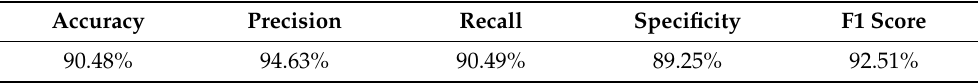
Table 3. Performance of Mask RCNN for image